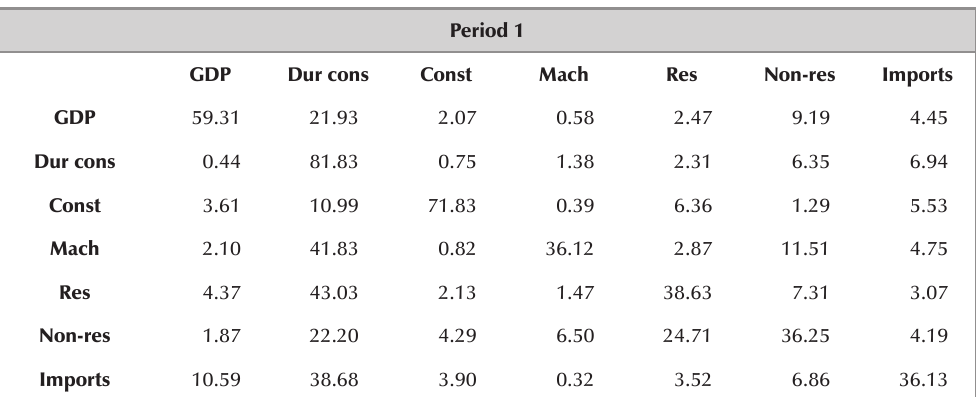
Variance decomposition: Periods 1–3 Period